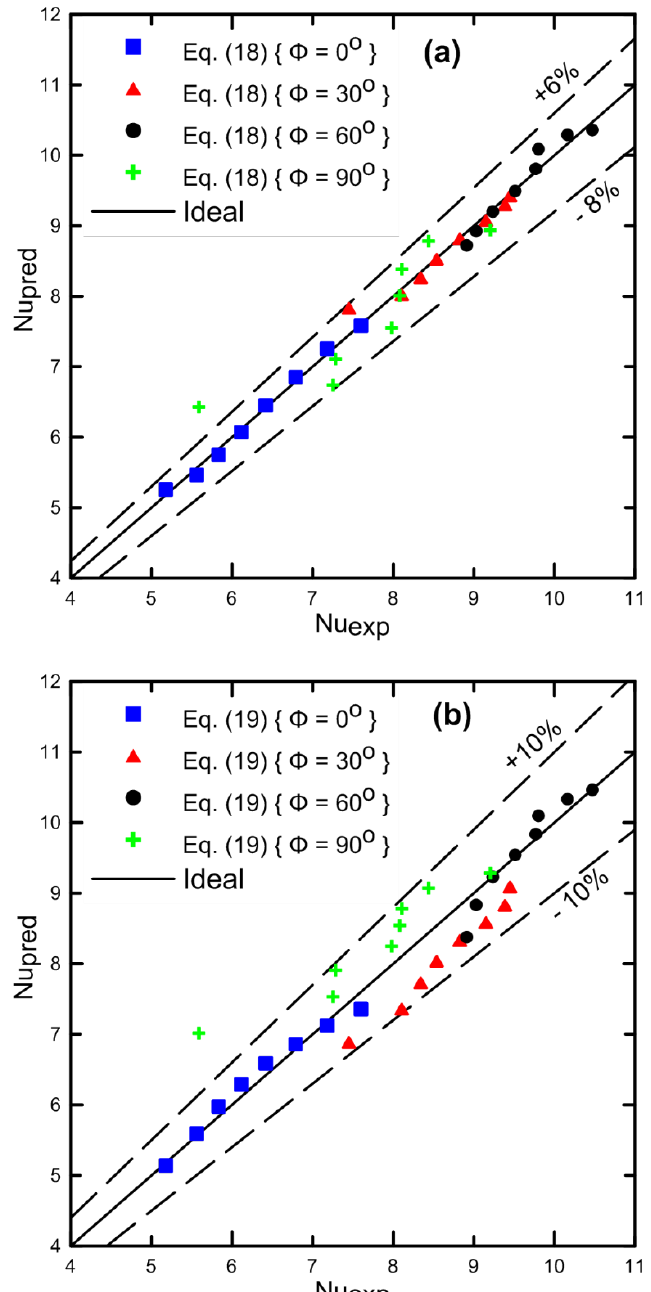
Figure 10. ( a , b ) Comparison between the experimental data and the predicted values of Nu in the cavity for the four tilt angles: φ = 0°, φ = 30°, φ = 60°, and φ = 90°. The dashed lines present the difference bandwidths. ( a ) The correlation of Equation (18); ( b ) the correlation of Equation (19).